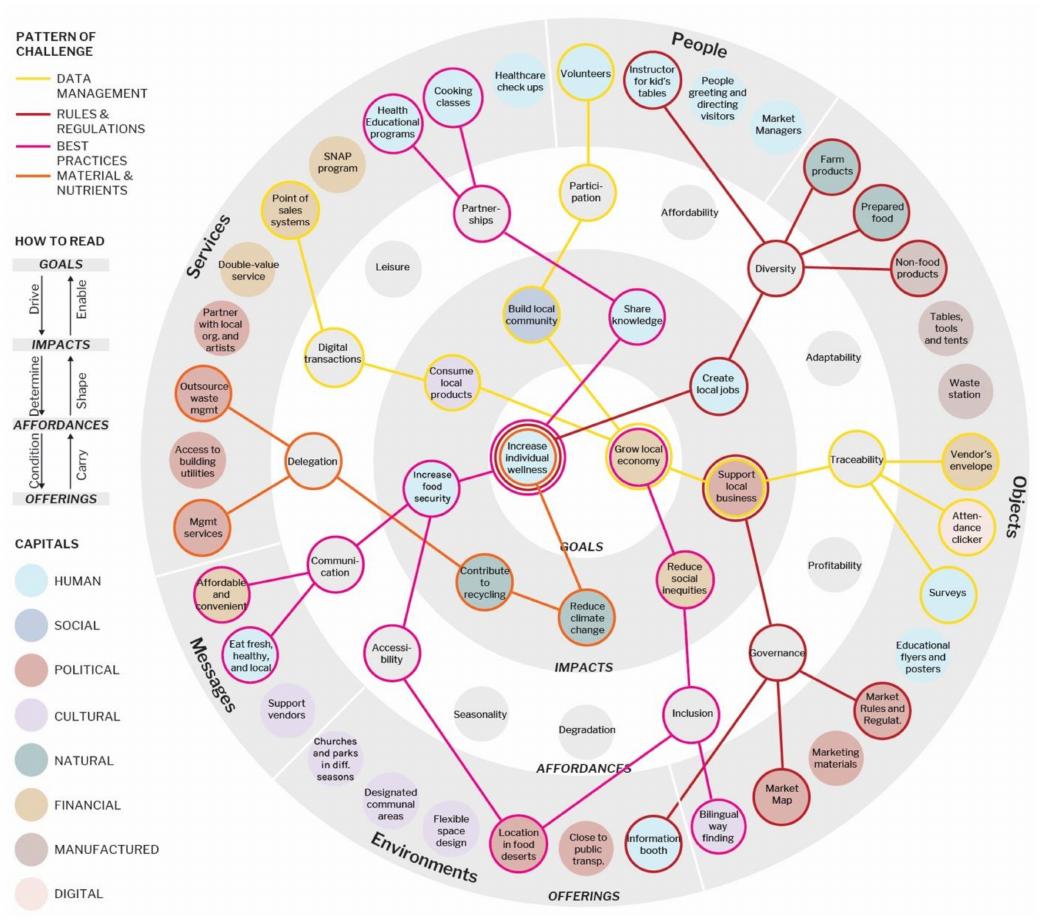
Figure 3. Anatomy of infrastructures underlying farmers markets in the City of